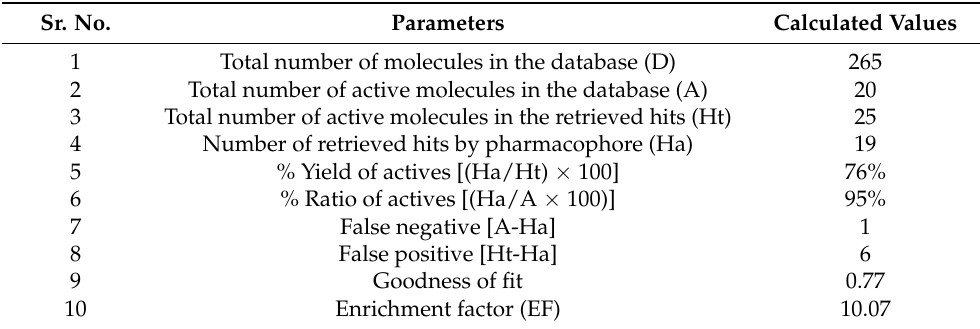
Table 2. Pharmacophore validation results from the GH method using a decoy test set. Sr.